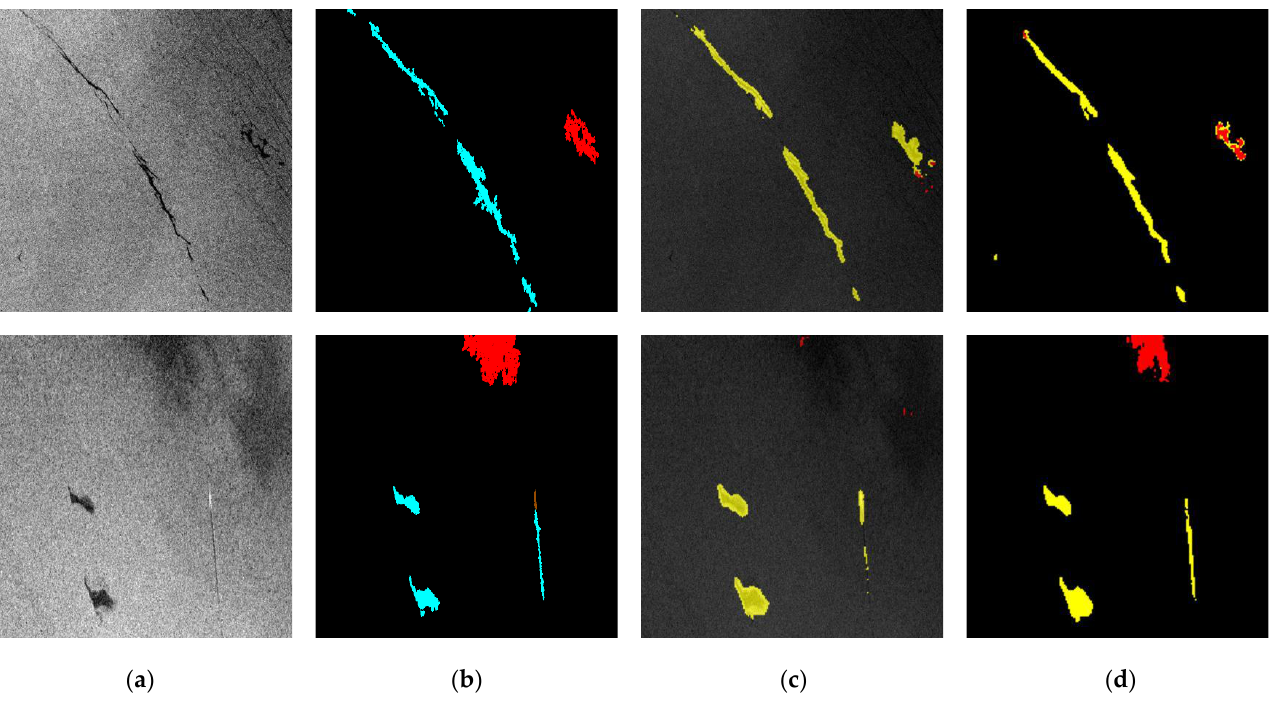
Figure 11. ( a ) SAR images, ( b ) Labels, ( c ) Segmentation results by baseline method, ( d ) Segmentation results of the proposed method. There are more errors in the recognition effect ( c ) for UNet compared with ( d ) for FMnet.